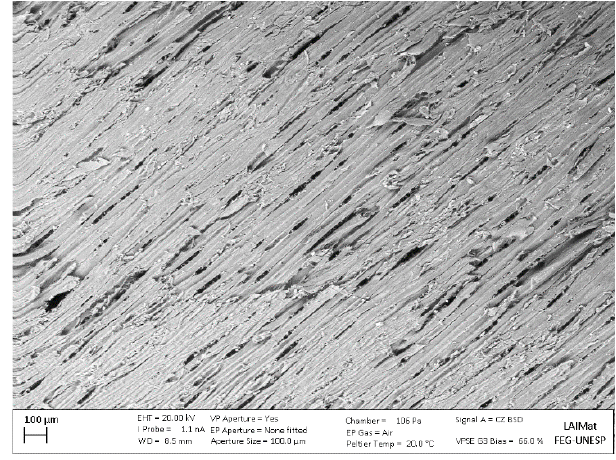
Figure 6. SEM image of veneer surface treated at 200 °C.